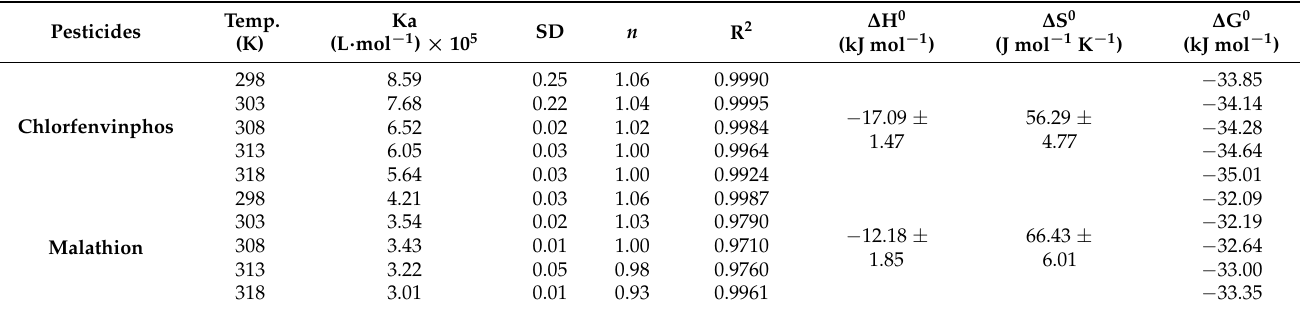
Table 4. The thermodynamic and binding data of the europium (III)–(vitB1) 2 complex with the OPPs under study.